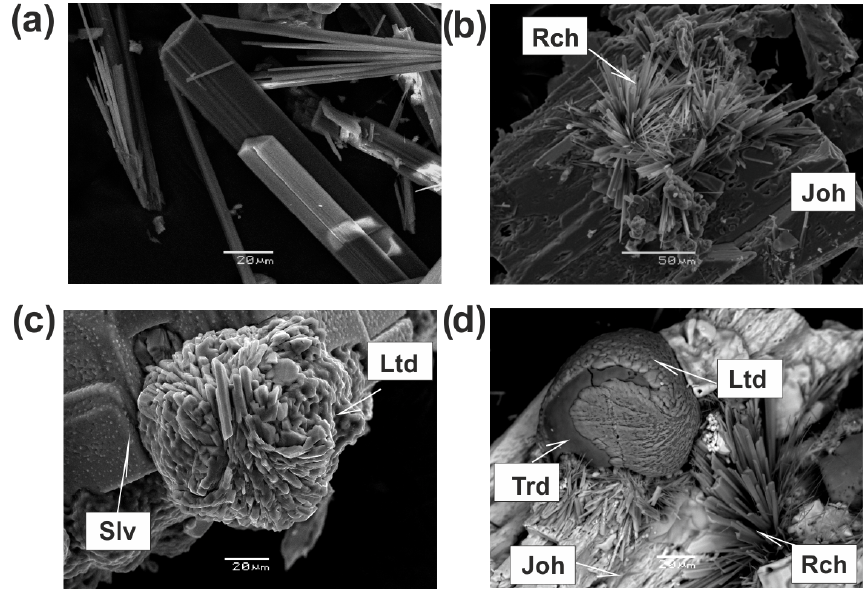
Figure 10. Long-prismatic to acicular crystals of potassic-fluoro-magnesio-arfvedsonite (a) , bush-like clusters of acicular crystals of potassic- fluoro-richterite (Rch) overgrowing johillerite (Joh) (b) , spherulite of litidionite consisting of split crystals on sylvite (Slv) (c) and shaggy aggregates of potassic-fluoro-richterite (Rch), with tridymite (Trd) spherulite partially covered by litidionite (Ltd) on crystal of johillerite (Joh) (d) . (a–c) SE images; (d) BSE image.